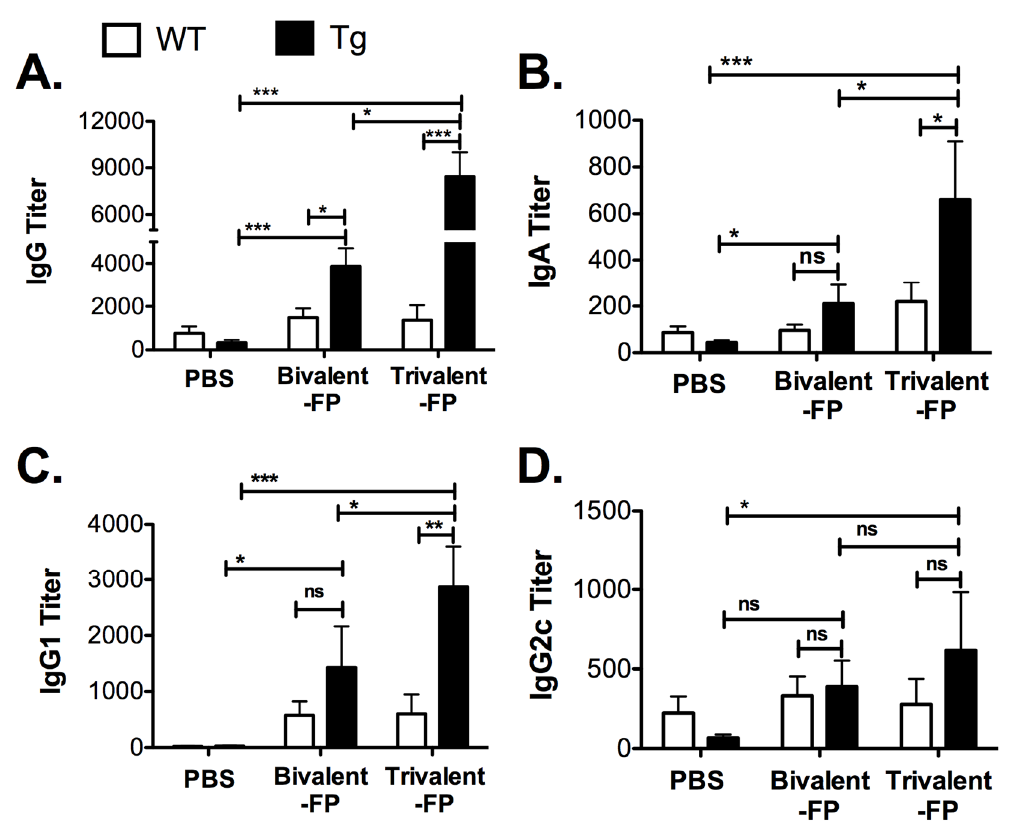
Figure 2. Trivalent-FP induced an S. pneumoniae -specific humoral immune response: groups of WT (wild type) and Tg (transgenic) mice were immunized with PBS, Bivalent-FP (208 pmol), or Trivalent-FP (208 pmol) via the intranasal route, and serum was obtained 11 days post-booster immunization. S. pneumoniae- specific IgG ( A ), IgA ( B ), IgG1 ( C ), and IgG2c ( D ) titers were evaluated by ELISA. Mean ± SE of data from two independent experiments is shown ( n = 12 / group, * p = 0.05, ** p = 0.01, *** p = 0.005, ns: not significant). Statistical significance between indicated groups was evaluated by Mann–Whitney nonparametric